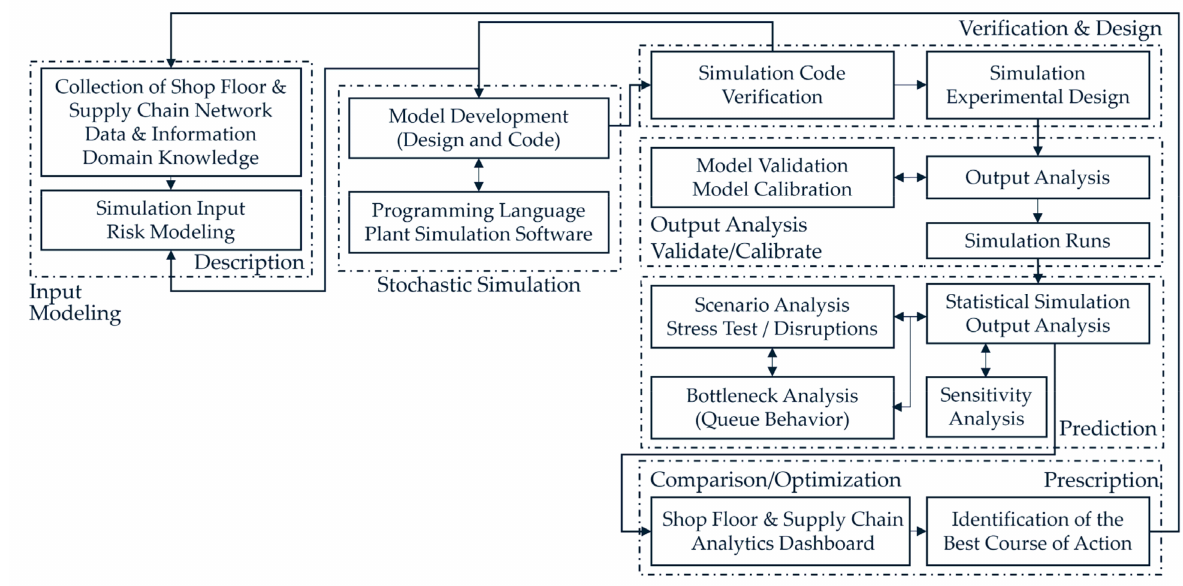
Figure 7. Factory analytics